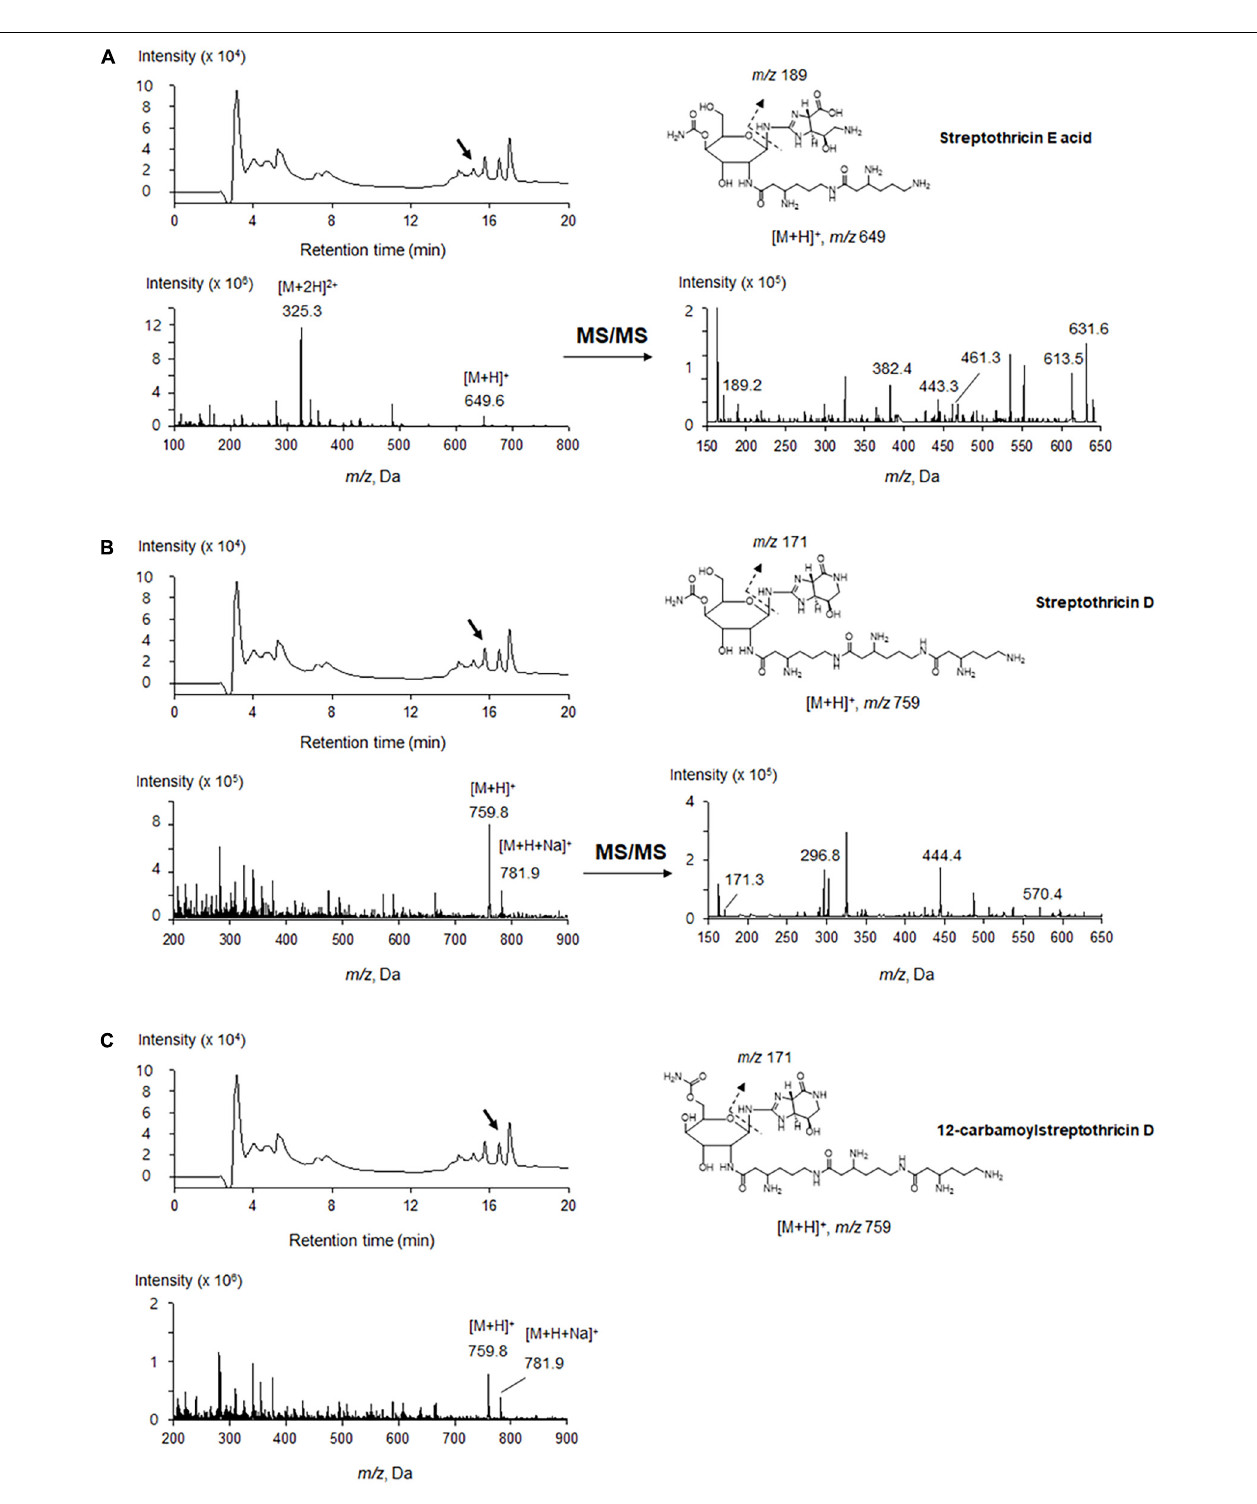
FIGURE 2 | LC-ESI-MS analysis of the compounds produced by Streptomyces sp. JCK-6131. Streptothricin E acid (A) , streptothricin D (B) , and 12-carbamoylstreptothricin D (C) . The LC chromatograms, mass spectra, and chemical structures with fragmentation patterns are shown.